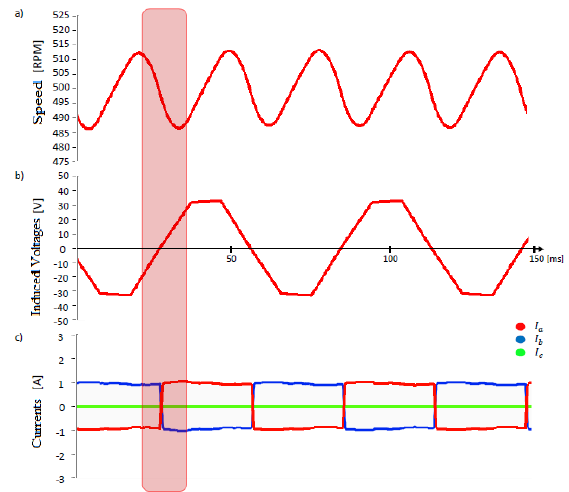
Figure 10. Numerical simulation of a BLDC motor under fault in phase c in 180 ◦ Six-Step operation mode with proposed flexibilization on reduction current strategy: ( a ) speed; ( b ) induction voltage E ab ; ( c ) phase currents I a , I b and I c .